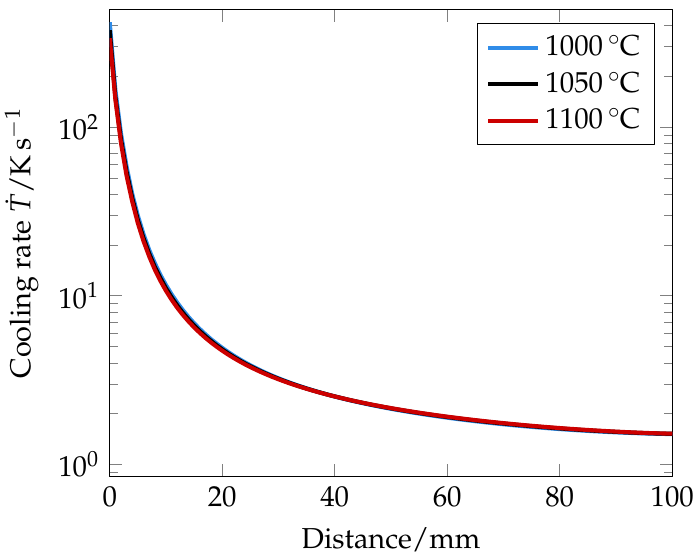
Figure 14. Cooling rate ˙ T calculated by FE simulation as a function of the distance (along the X axis equal to 12 mm from Y=0 mm to Y=100 mm)